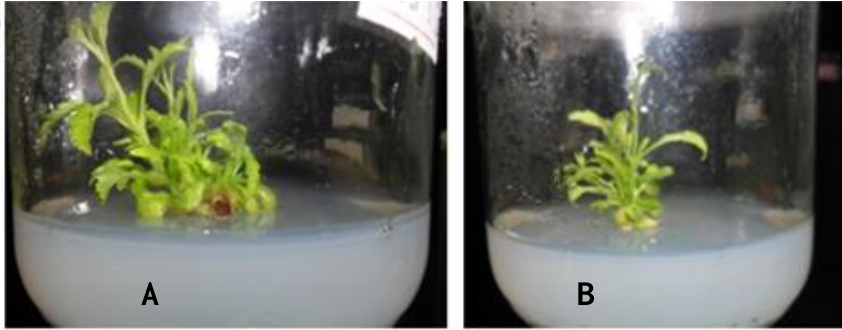
Figure 2: Elongation of established shoots of O. stamineus on MS medium with concentration of A) 0.5 ppm GA 3 and B) 1.0 ppm GA 3 after 2 weeks of culturing After elongation stage, explants that produce abundant shoots were excised and were cultured on MS medium with two different concentrations of NAA which 0.2 ppm and 0.5 ppm were. After week 4 of culturing, it was observed that 0.2 ppm of NAA gave 100% response while 0.5 ppm NAA did not gave any response (Figure 3). The longest root